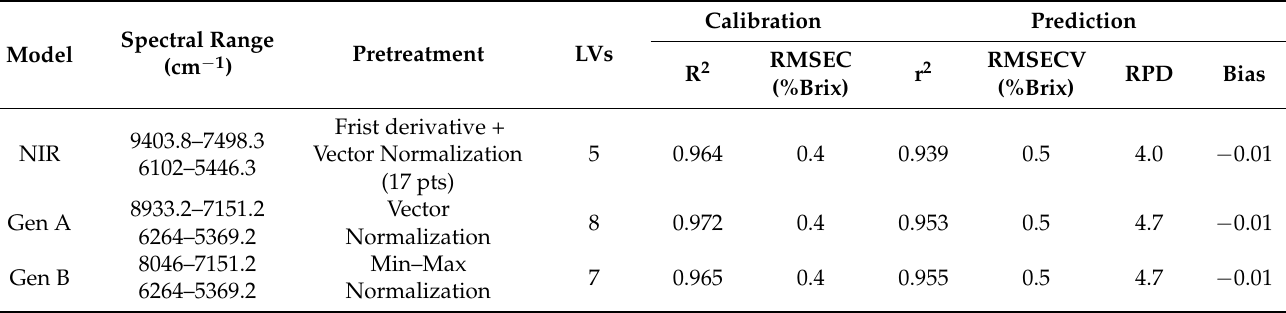
Table 3. PLSR models for mango pur é e TSS prediction.